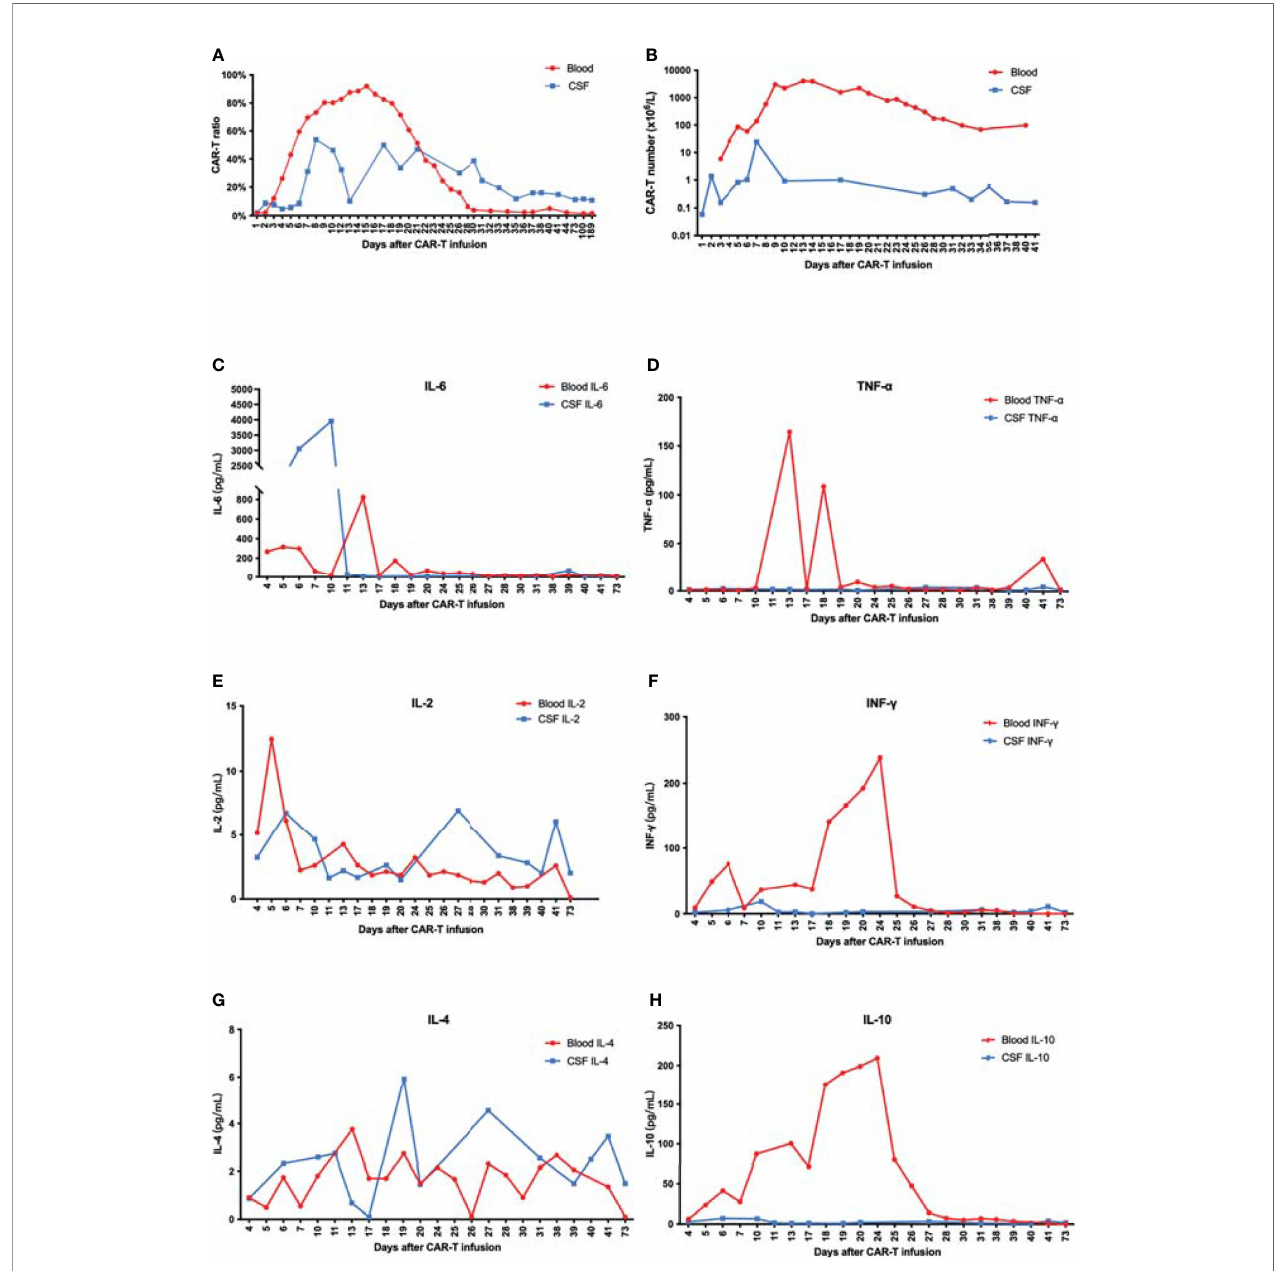
FIGURE 3 | (A) The proportion of CAR-T cells in CD3-positive cells increased and reached a peak at 7 or 15 days after CAR-T infusion. (B) The number of CAR-T cells in peripheral blood far exceeded that in CSF. (C – H) IL-6 increased rapidly in CSF and was signi fi cantly higher than that in blood. There was no signi fi cant difference of IL-2 and IL-4 between peripheral blood and CSF. Moreover, IL-10, TNF- a , and IFN- g in peripheral blood signi fi cantly exceeded that in